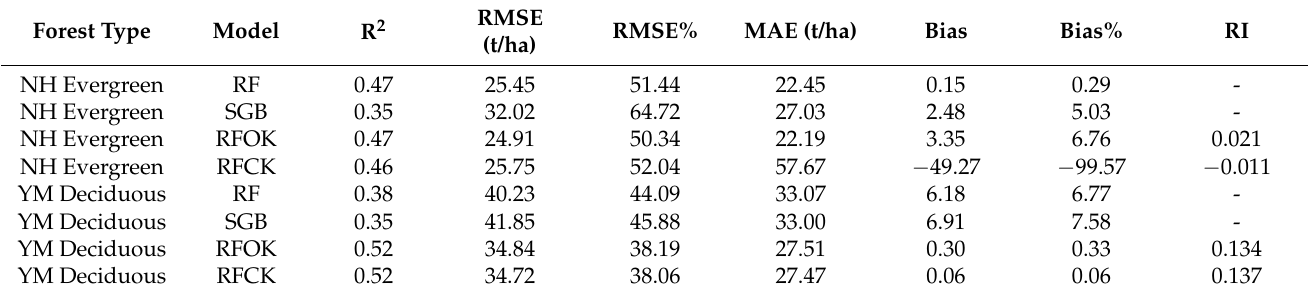
Table 5. Validation metrics of RF, SGB, RFOK, and RFCK models based on 20% of the sampled data.